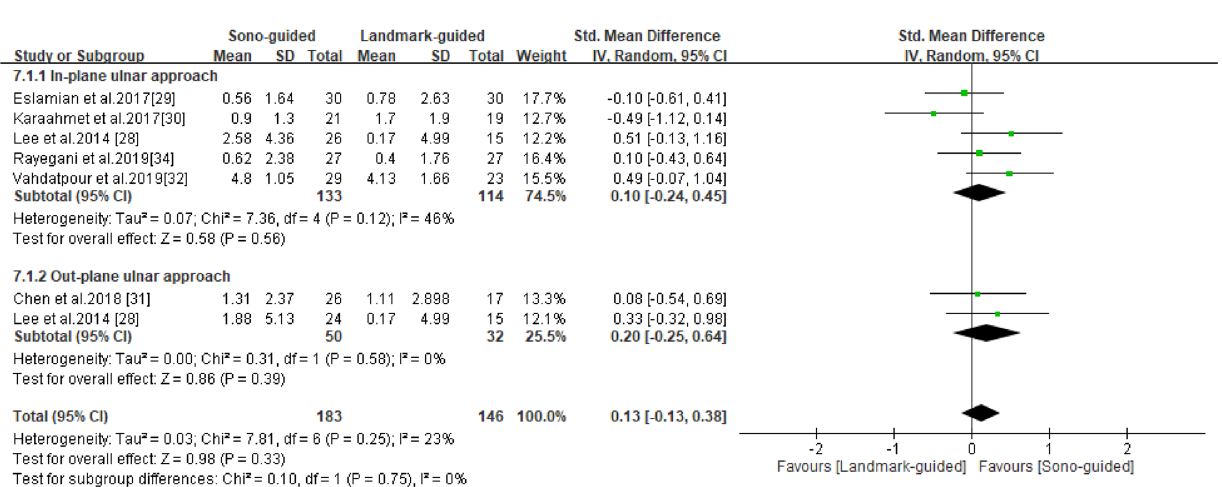
Figure 7. Forest plot for DML. US-guided, ultrasound guided; LM-guided, landmark guided.